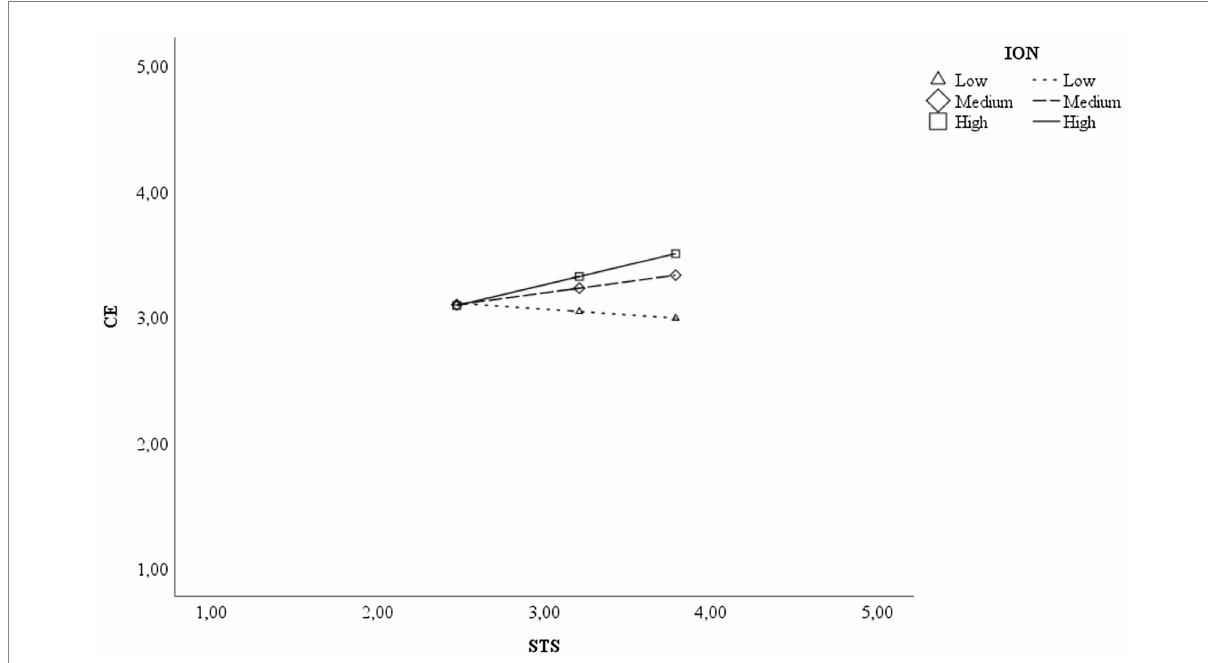
FIGURE 1 Interactive effect of STS and ION on CE. STS, support from teaching staff; ION, interaction online; CE, career